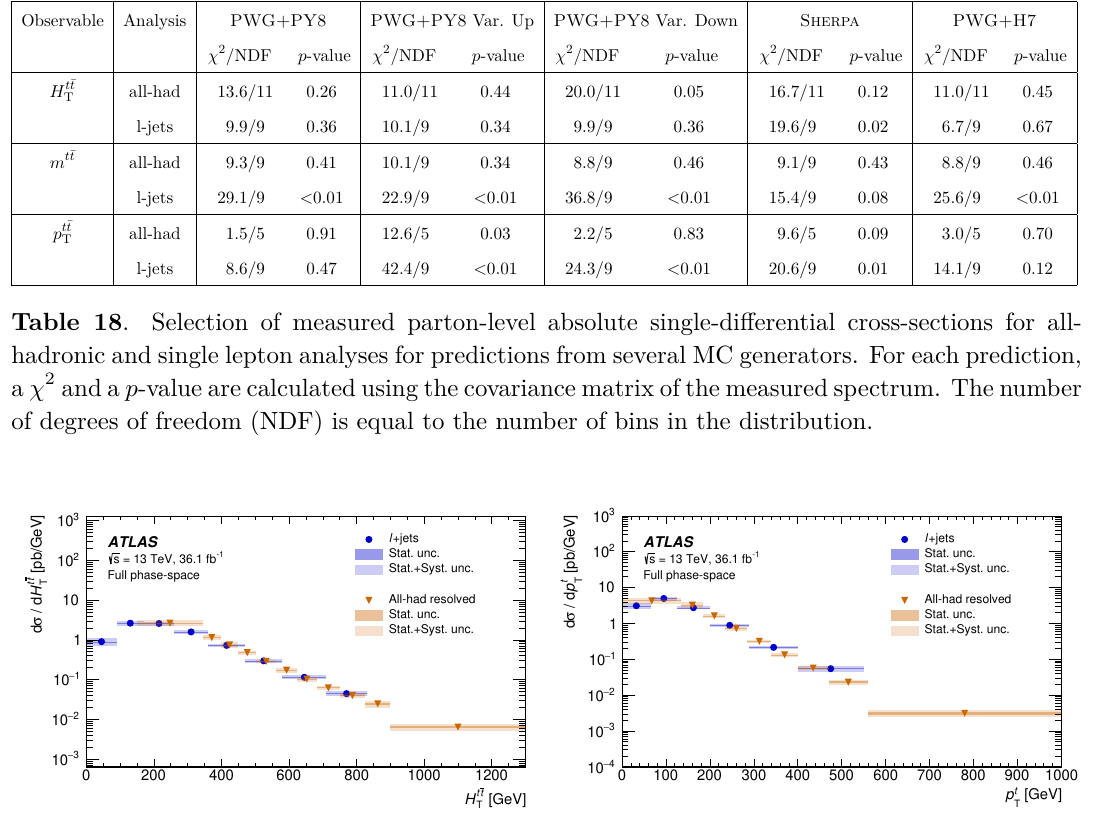
and (b) the average top transverse momen- T